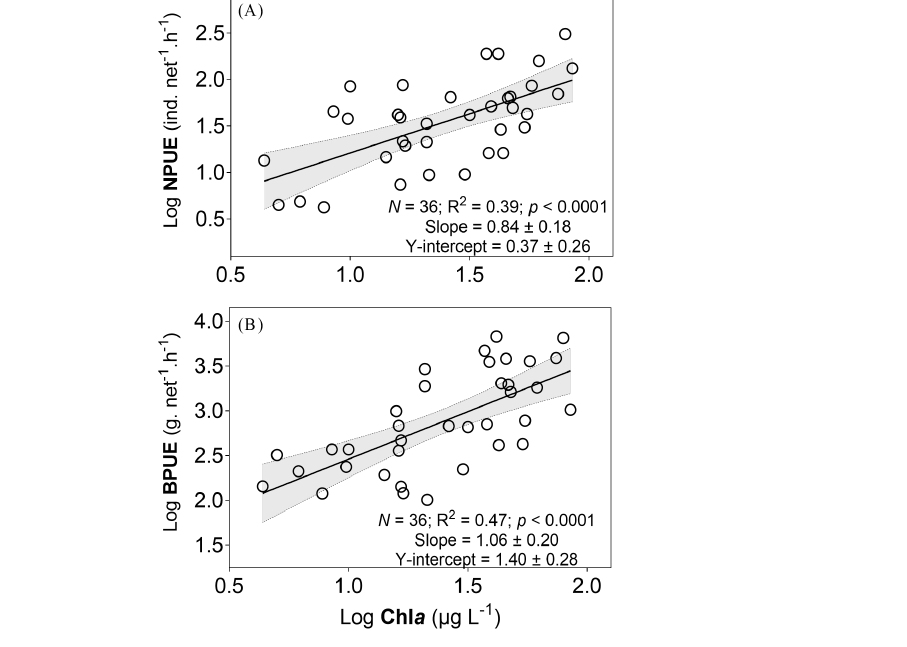
Figure 4. Relationships between fish catch per unit effort (NPUE, number per unit effort ( A ); BPUE, biomass per unit effort ( B ) and Chl a . N , number of lakes; Chl a , chlorophyll- a concentration in phytoplankton. The dashed lines represent the 95% confidence band.